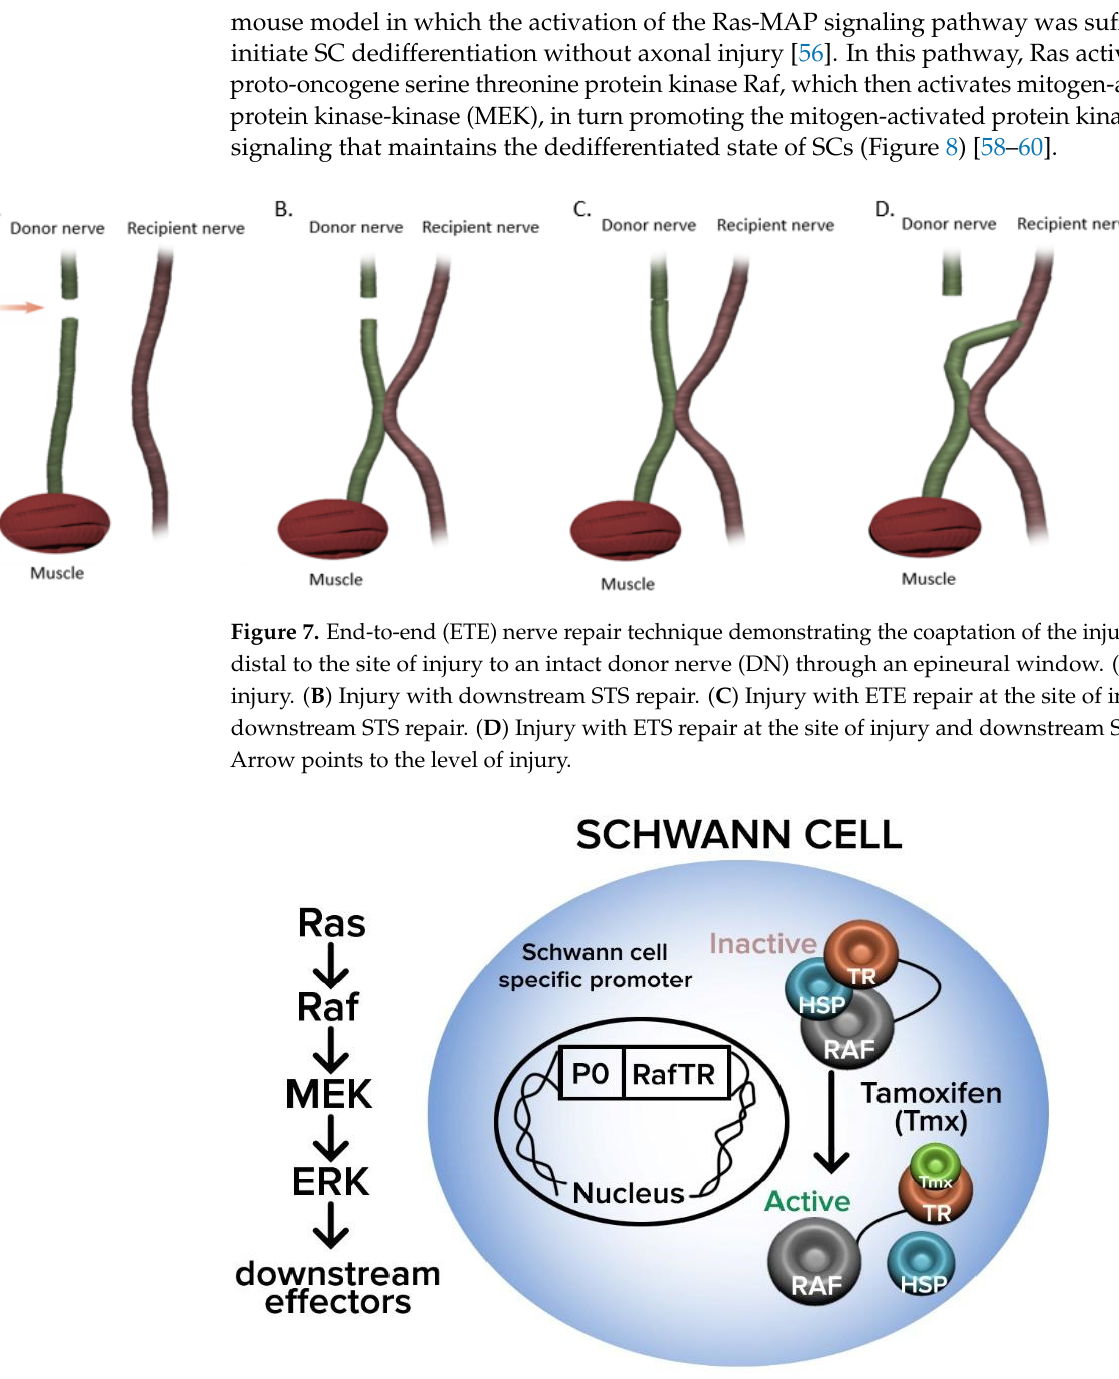
Figure 8. Ras-MAP signaling pathway for Schwann cell dedifferentiation as proposed by Napoli et al. Ras activates protein kinase Raf, which then activates mitogen-activated protein kinase-kinase (MEK), in turn promoting mitogen-activated protein kinase (ERK) signaling that then maintains the de-differentiated state of Schwann cells. TR = Tamoxifen-inducible RAF-Kinase; HSP = Heat Shock Protein; RAF = Rapidly Accelerated Fibrosarcoma (Adapted from Napoli et al. [60]).